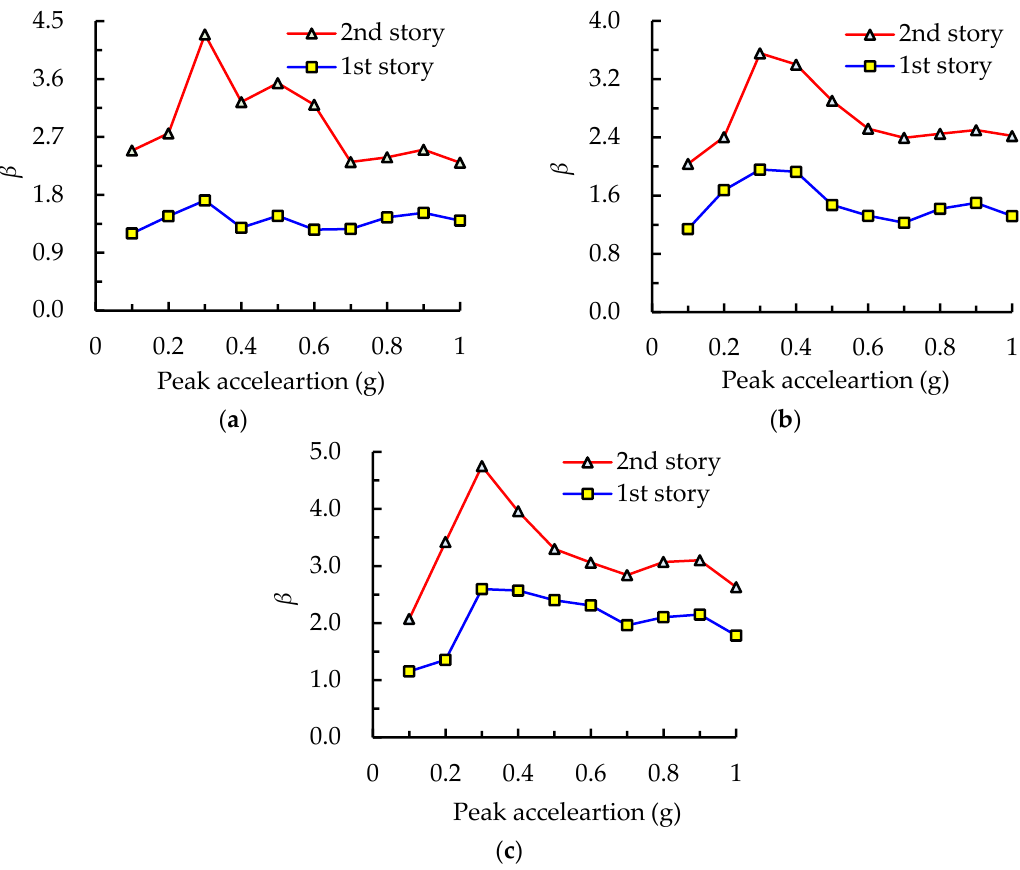
Figure 18. Acceleration amplification factor. ( a ) El Centro wave; ( b ) Kobe wave; ( c ) Taft wave.